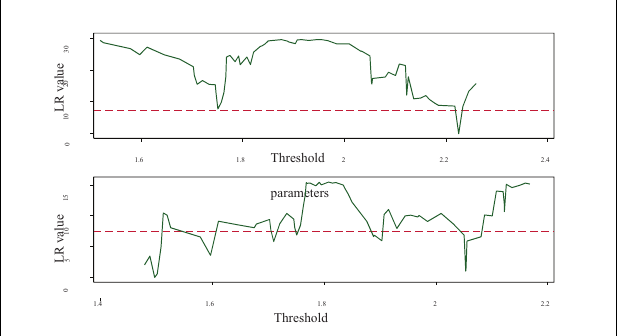
FIGURE 3 | Likelihood ratio function graph of threshold